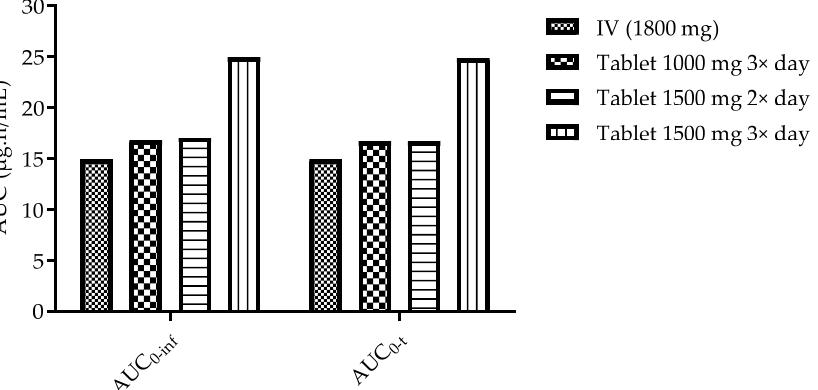
Figure 3. Comparison of AUC between IV infusion (1800 mg), 1000 tablet 3 × a day and 1500 mg tablet 2 × and 3 × a day.